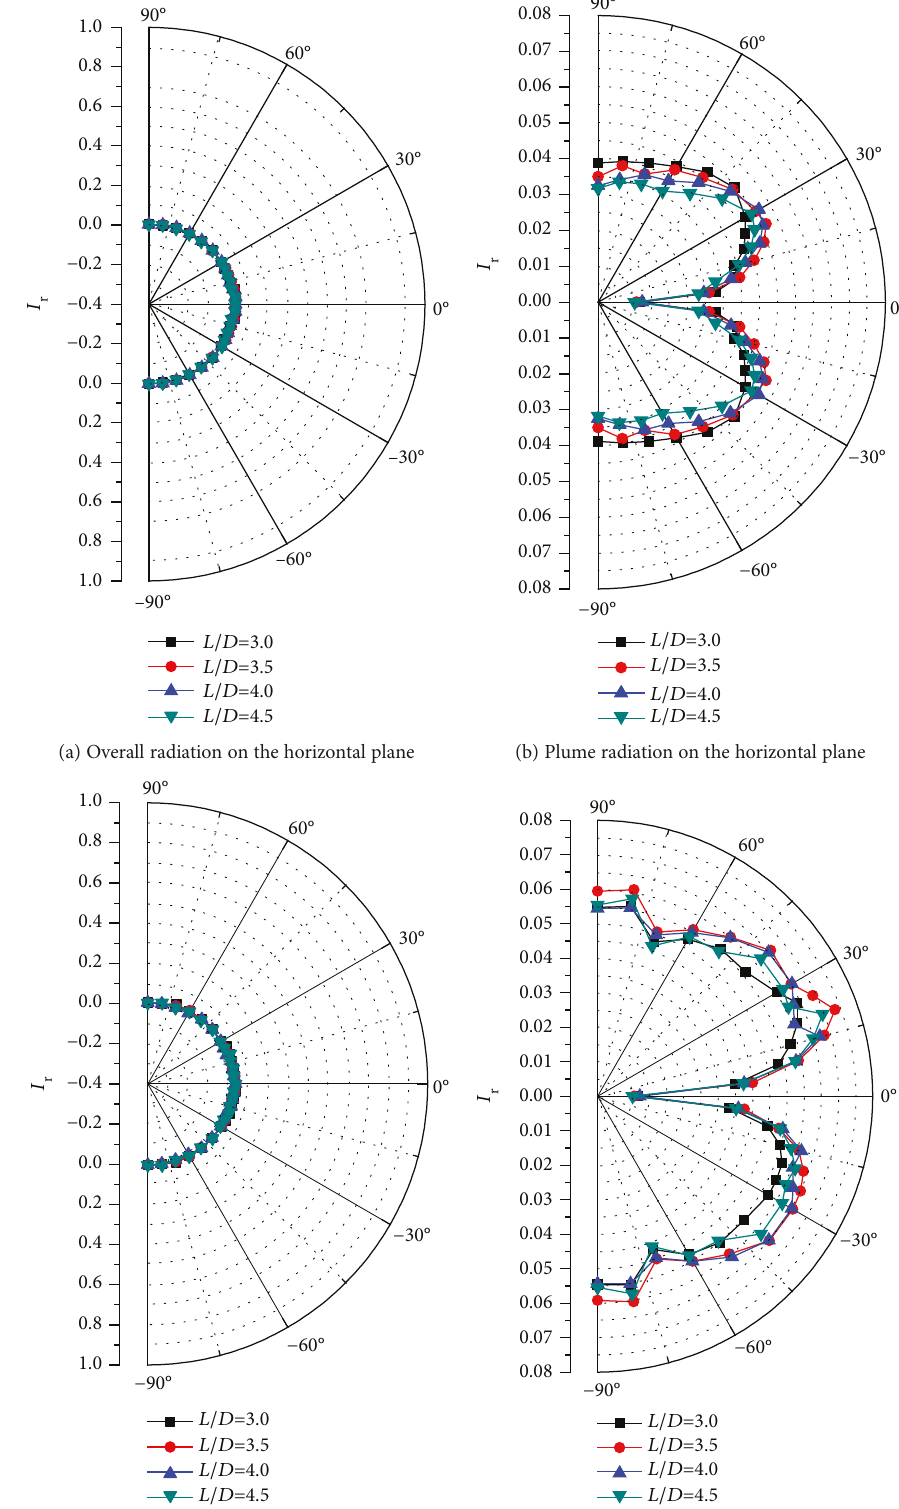
Figure 25: Infrared radiation of exhaust systems in the band of 3-5 μ m varying L / D